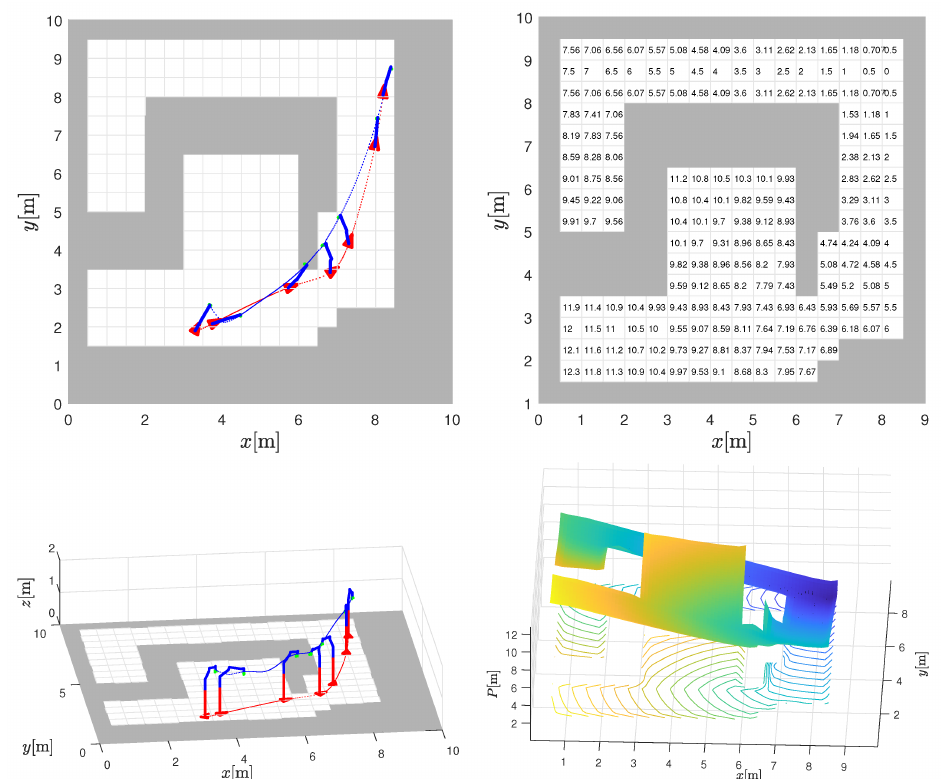
Figure 1. The desired trajectory of the end effector is marked with a blue dotted line, and the achieved path of the base is marked with a red dotted line. The movement of the mobile base is restricted to a free corridor marked by white square cells ( top left and bottom left ). The discrete potential field for the distance to the target ( top right ) is obtained by the graph-based search to the target location at [ 8.25,8.75 ] m. A smooth interpolated potential field navigation function ( bottom-right ) is used to control the mobile base to support tracking of the desired end-effector